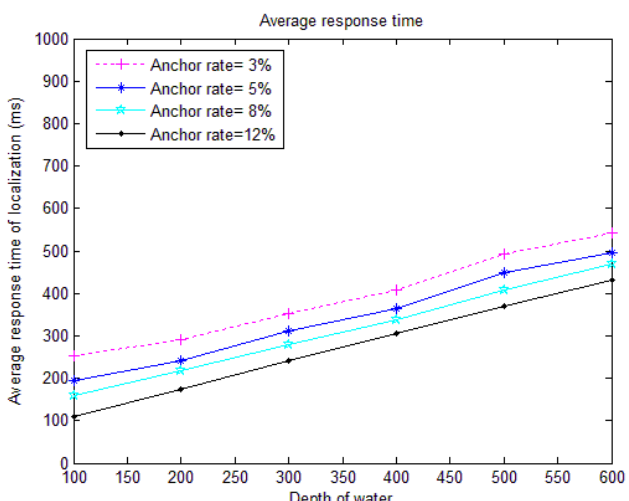
Figure 10. Average response time of